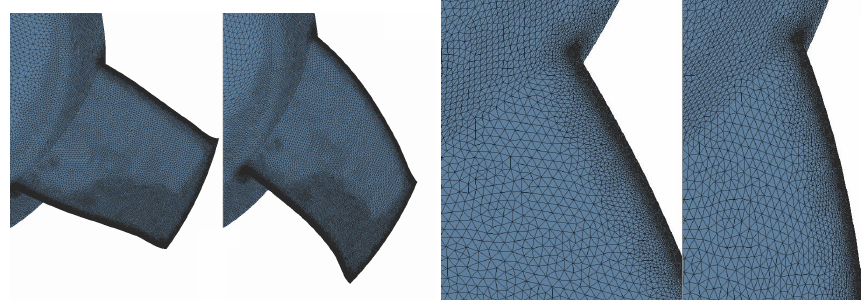
Figure 3. Deformation example: sweep angle variation and the zoomed view to the trailing